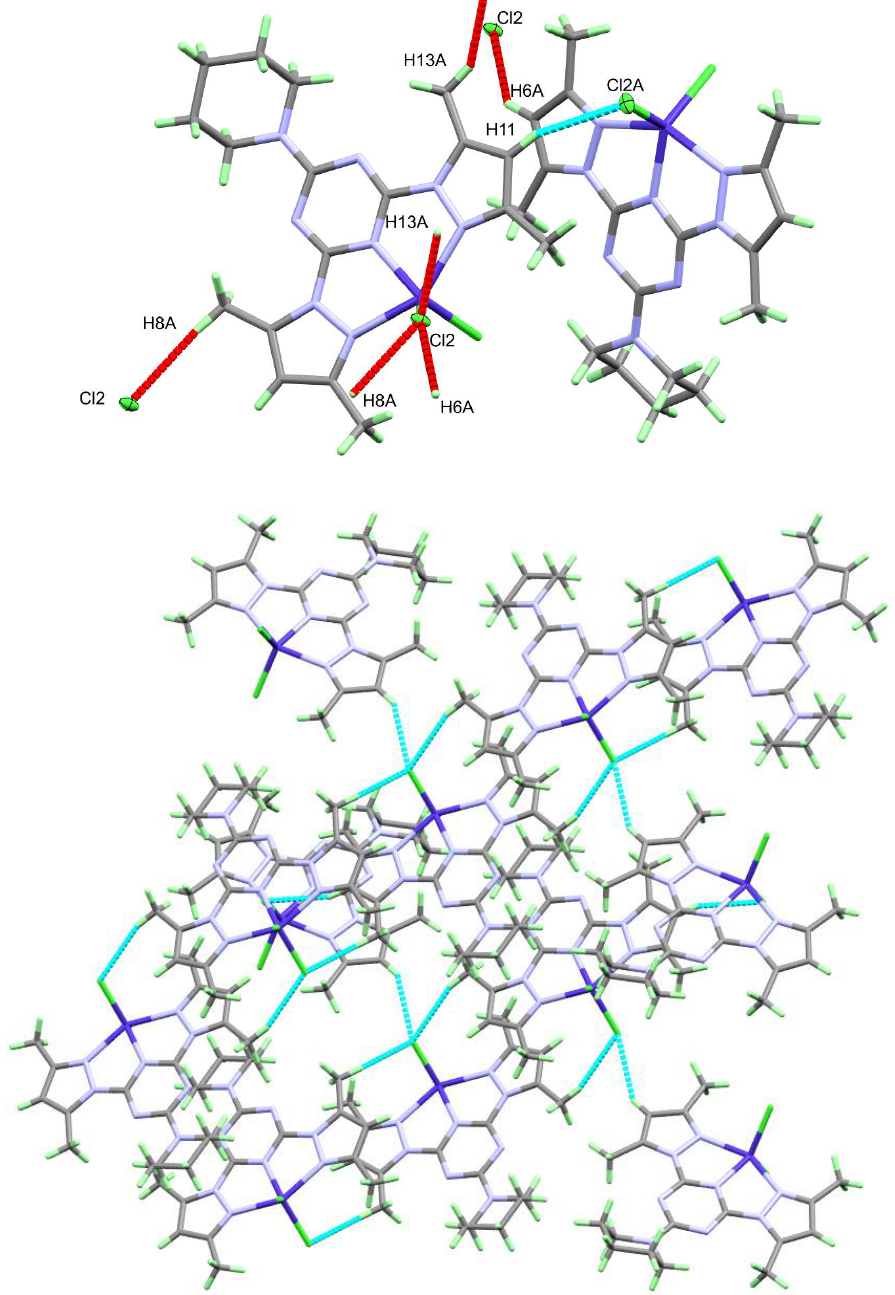
Figure 5. The hydrogen bond contacts (upper) and hydrogen bonding network (lower) in 2 .